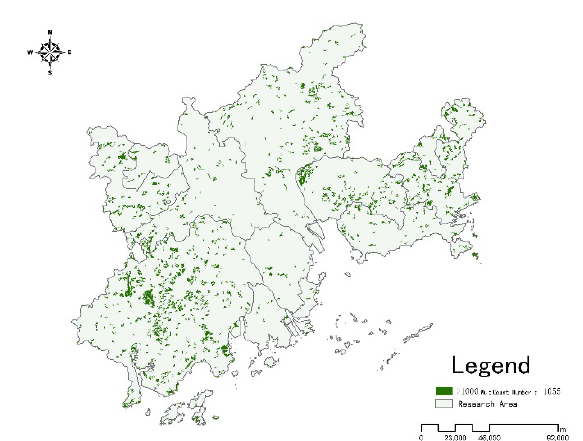
Figure 3: The study object’s (afforest-able patches) area is mainly for greater than 1000 mu (66.6 hectares) in Pearl river delta. Figure3: The study objects are nearly 1000 patches divided four main nodes (Northern, Western, Eastern and Southern) in Pearl river delta of Guangdong